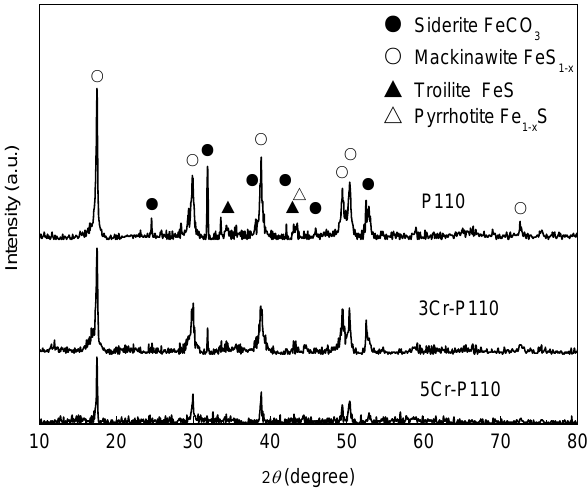
Figure 3. X-ray diffraction (XRD) spectra of corrosion scales on the steels with different Cr contents.